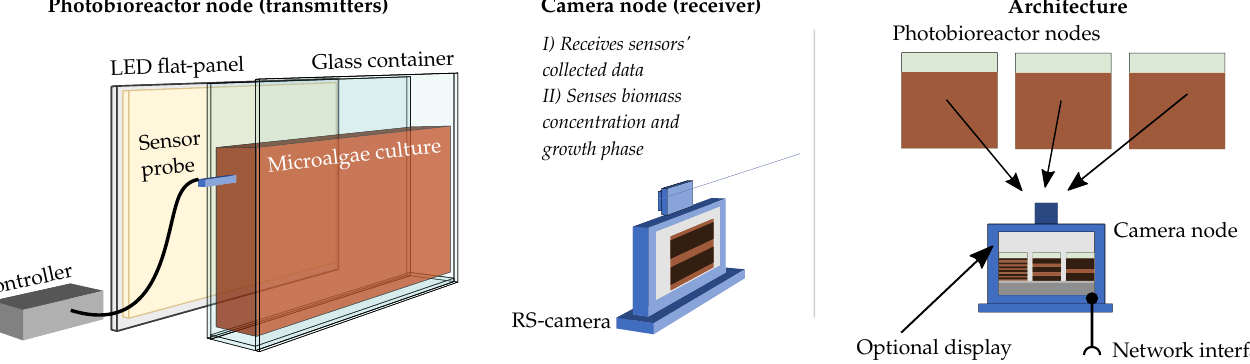
Figure 1. Proposed architecture based on flat-panel photobioreactors. RS,